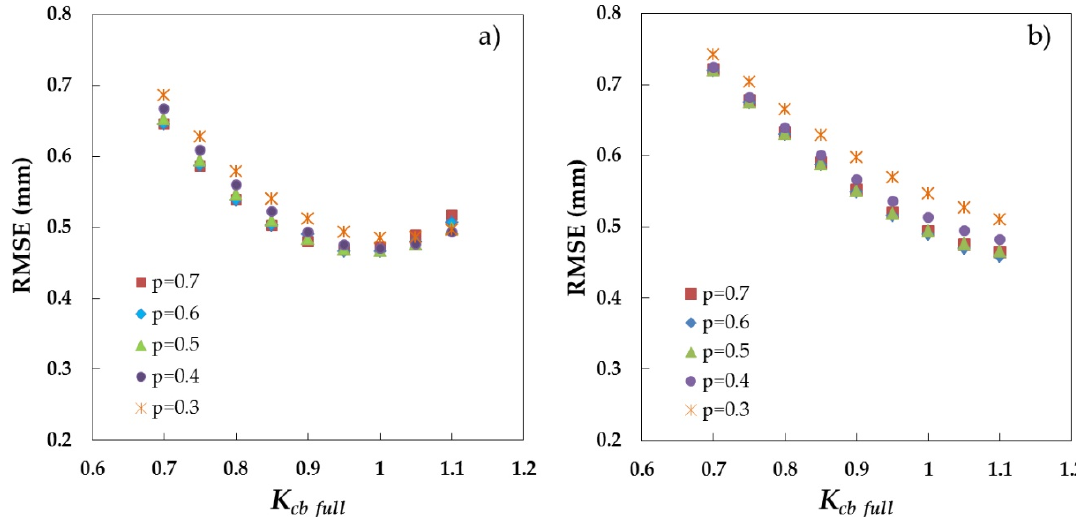
Figure 2. Performance (Root Mean Square Error, RMSE) of the soil water balance over the ( a ) dehesa ecosystem and ( b ) grassland area, with a range of basal crop coefficients for full cover vegetation ( K cb full ) (0.7–1.1) and depletion fractions ( p ) (0.3–0.7) parameters.